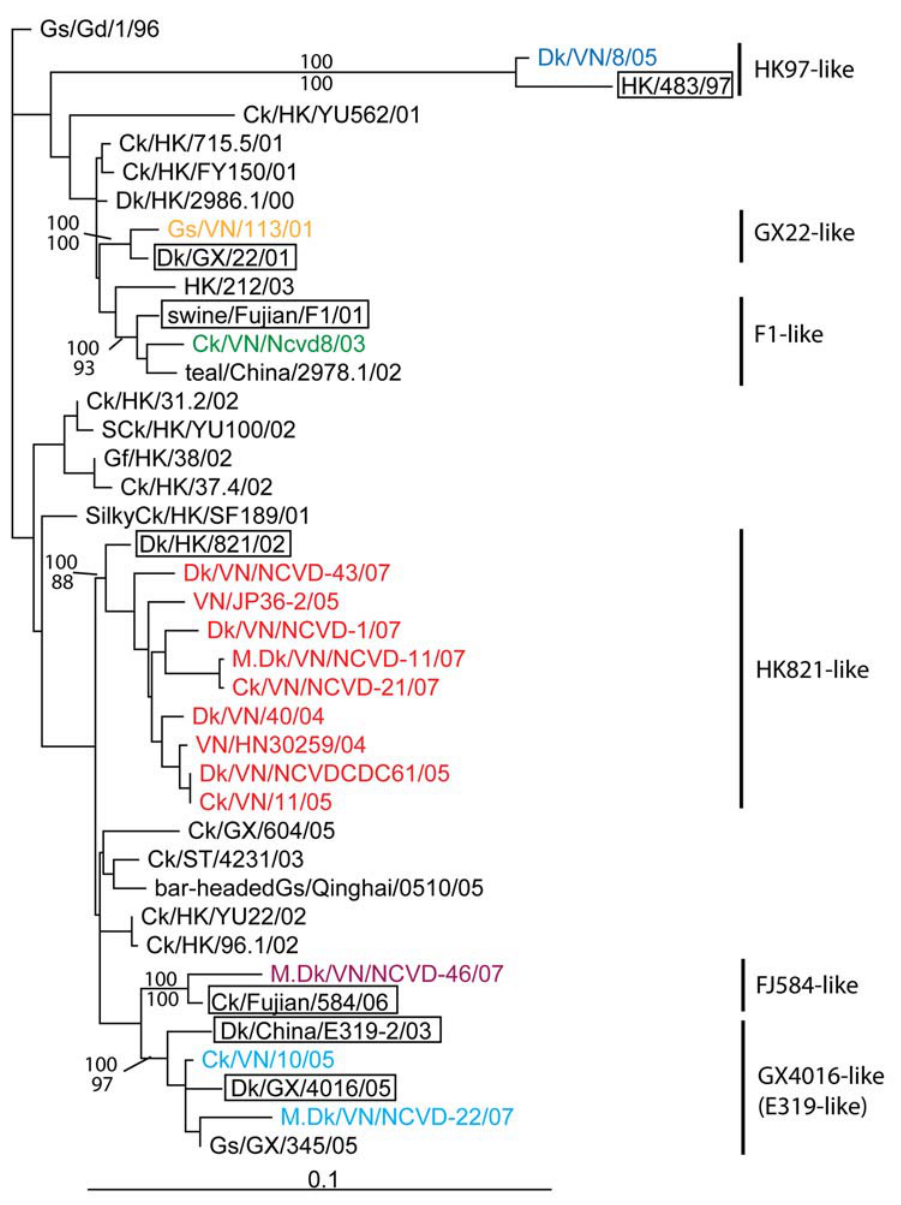
Figure 3. Phylogenetic tree of the NA gene of HPAI H5N1 viruses. The phylogenetic tree was constructed by Maximum Likelihood using GARLI version 0.951 [34] by selecting GTR + G model from Modeltest 3.7 [37]. Posterior probabilities and bootstrap values were given above and below branches, respectively. The tree was rooted by Gs/GD/1/96. The predicted precursor viruses were shown in boxes.